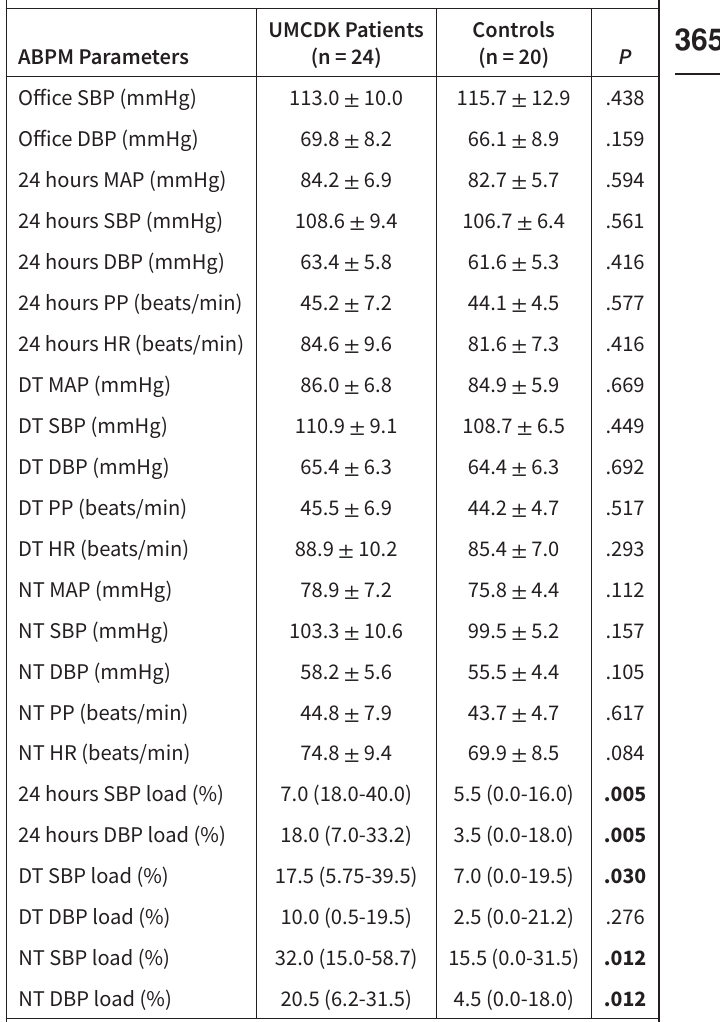
Table 2. ABPM Parameters of the Patients with UMCDK